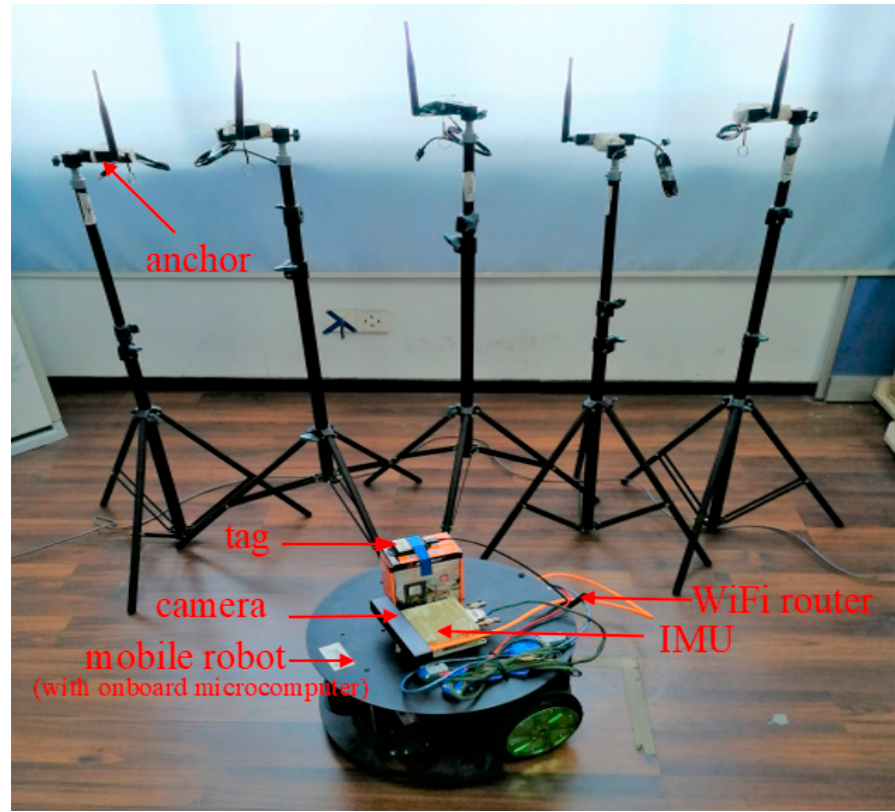
Figure 1. The platform of the positioning system.